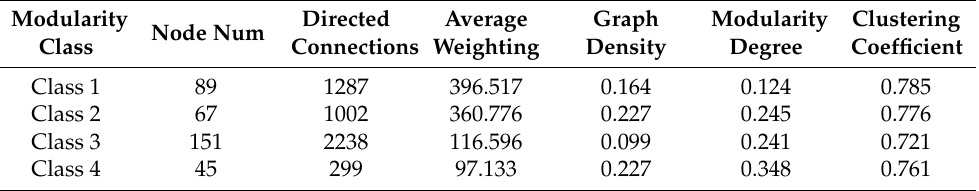
Table 2. Calculation results of community attributes of complex